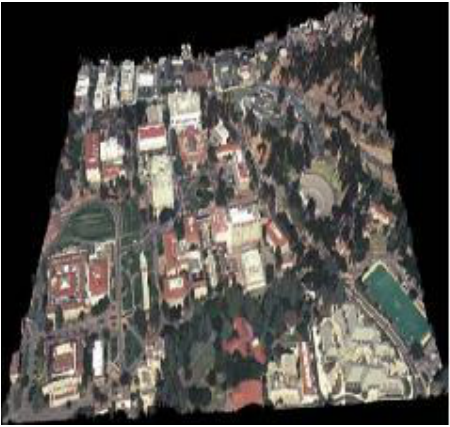
Fig.14- Texture mapped model of the Berkeley Campus (Source- Fruh and Zakhor, 2003).